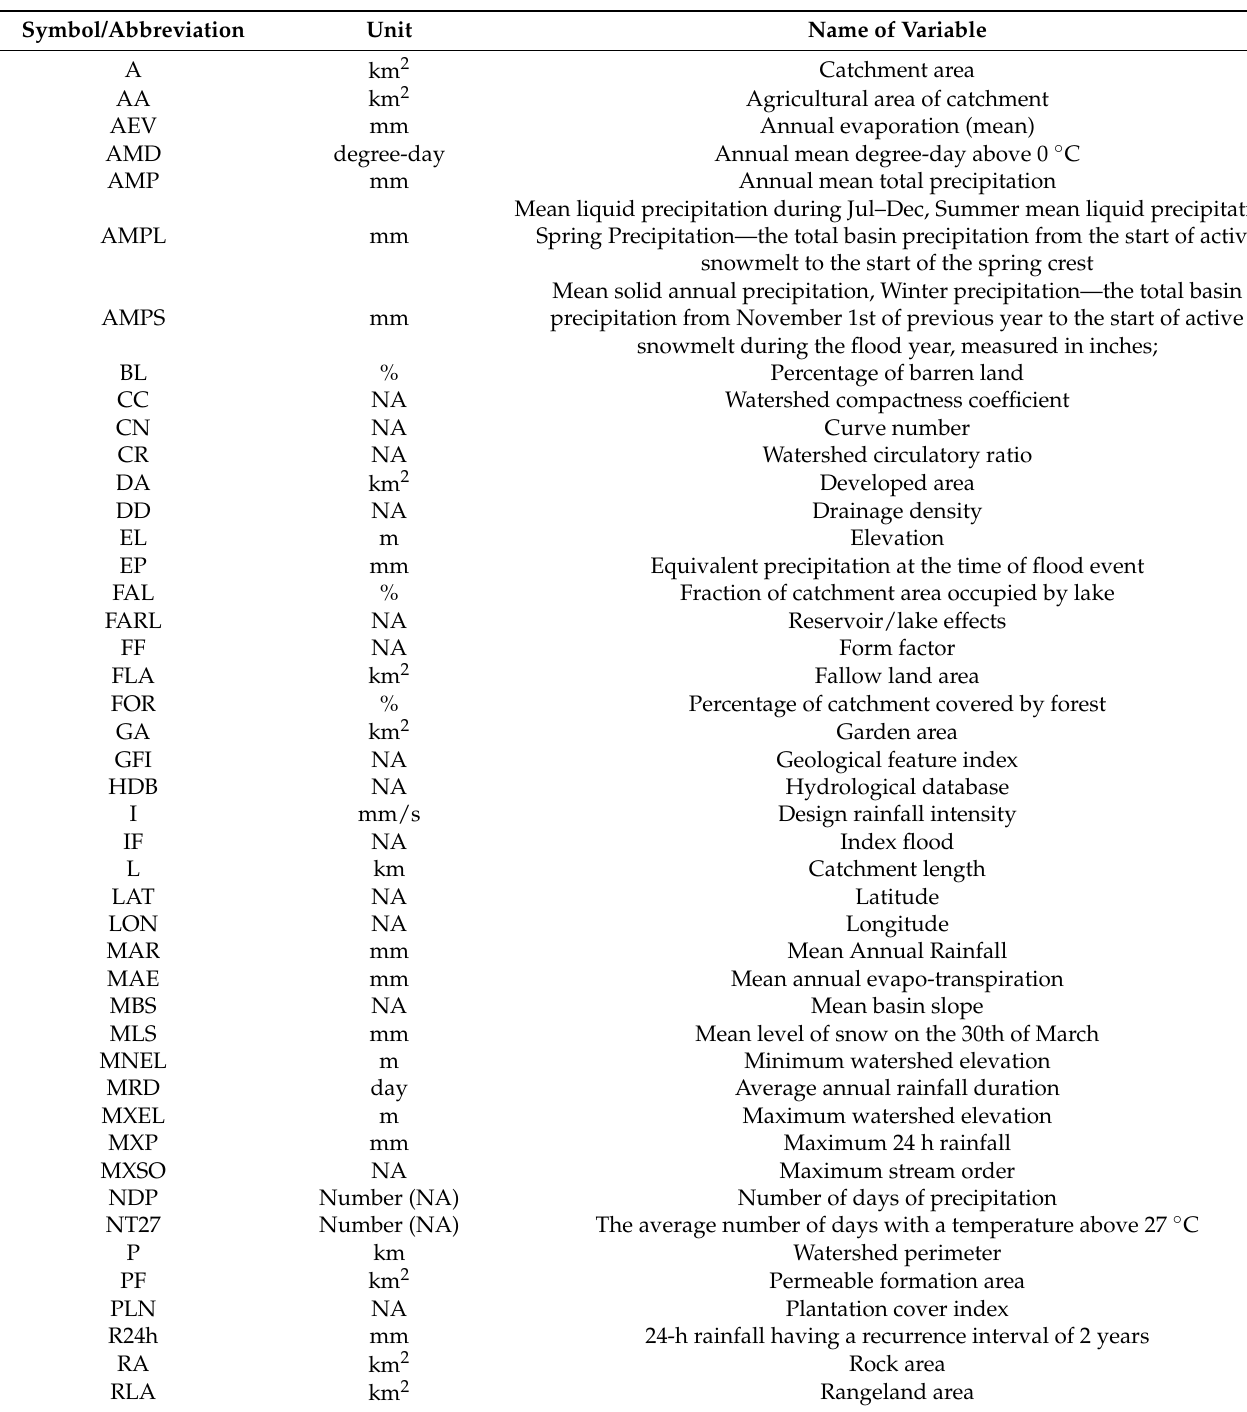
Table 2. Symbols and abbreviation of predictor variables used in Table